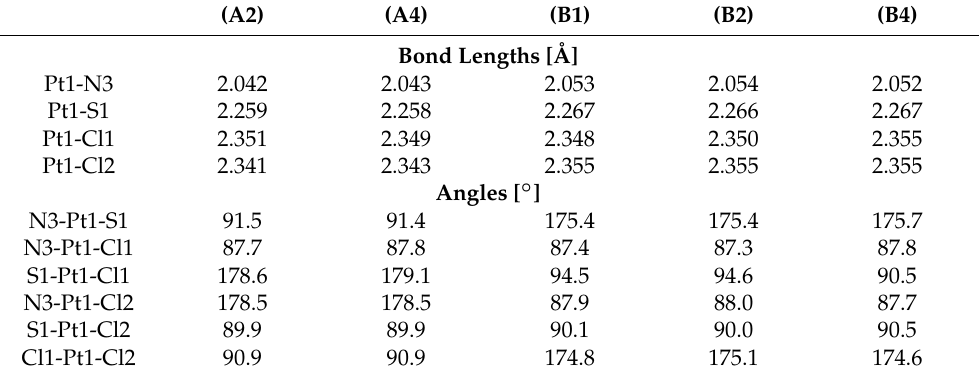
Table 2. DFT computed values of selected bond lengths (Å) and angles ( ◦ ) for ( A2 , A4 , B1 , B2 , B4